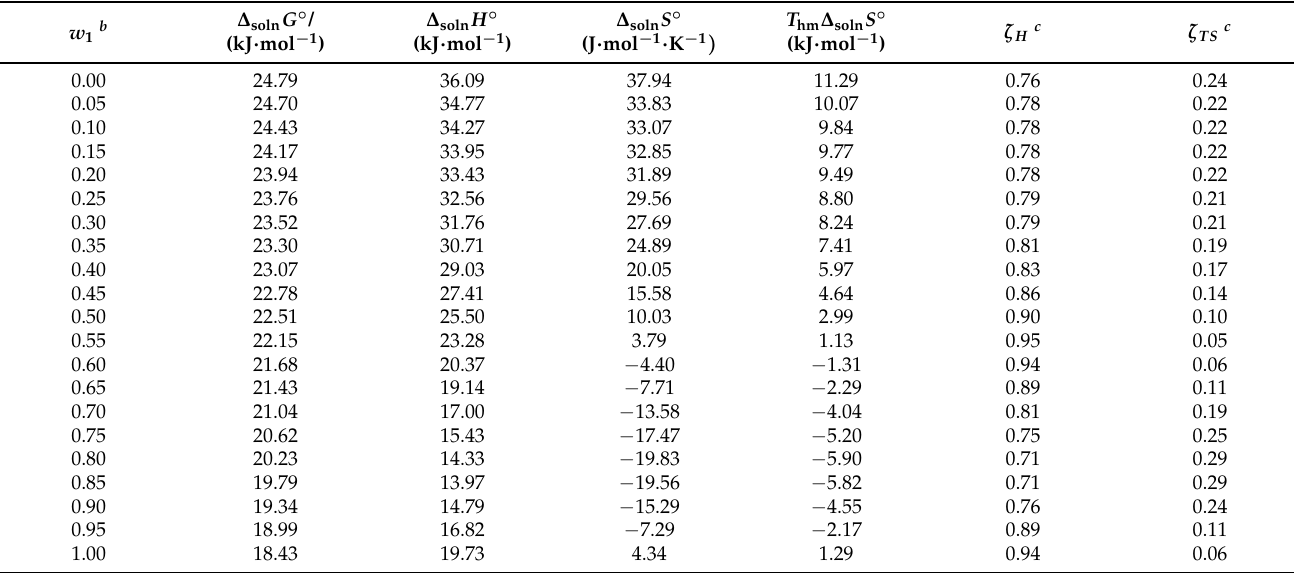
Table 5. Thermodynamic functions of the solution process of sulfadiazine (3) in {acetonitrile (1) + 1-propanol (2)} co-solvent mixtures at T hm = 297.6 K a . ∆ ◦ soln G w 1 b